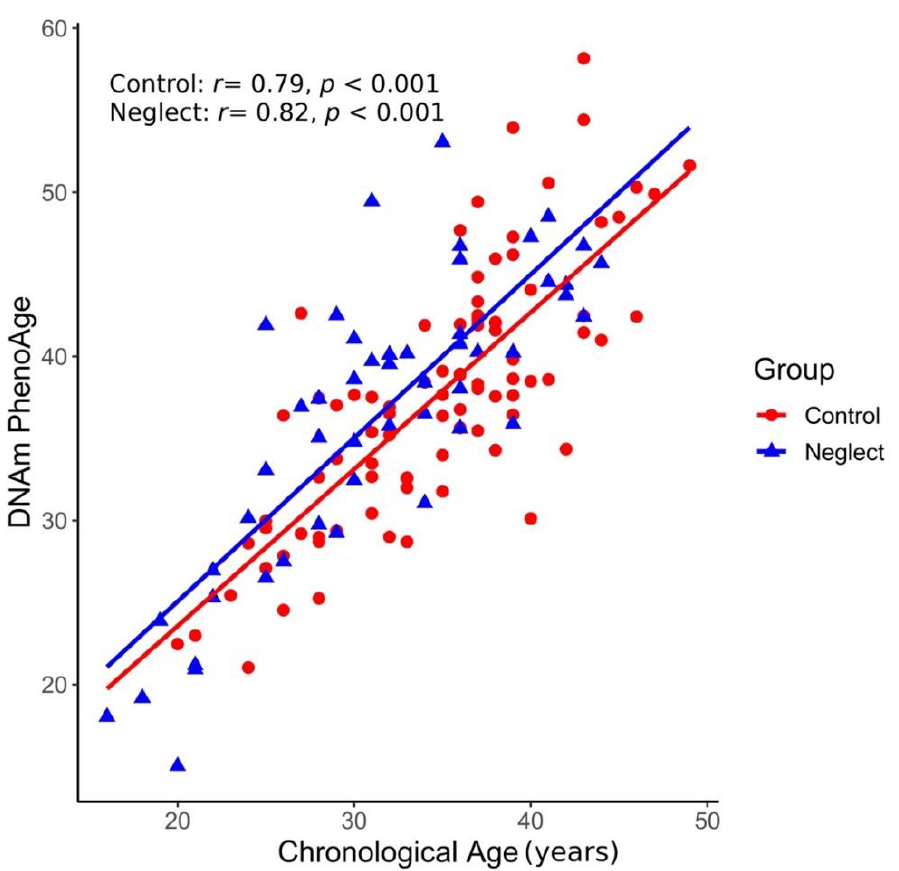
Figure 1. Relationships between epigenetic age and chronological age in Control and Neglect Groups. The scatterplot illustrates the significant and positive correlations between PhenoAge and chronological age (in years) for each group (red color corresponds to mothers and estimated regression lines in the Control Group and blue color corresponds to mothers and estimated regression lines in the Neglect Group).